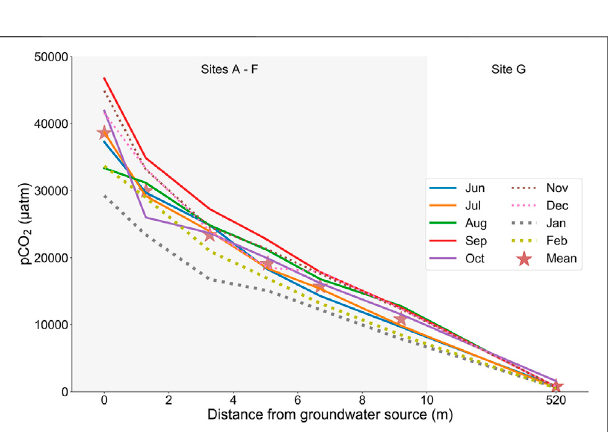
FIGURE 4 | The longitudinal changes in pCO 2 as a function of distance downstream from the groundwater source.